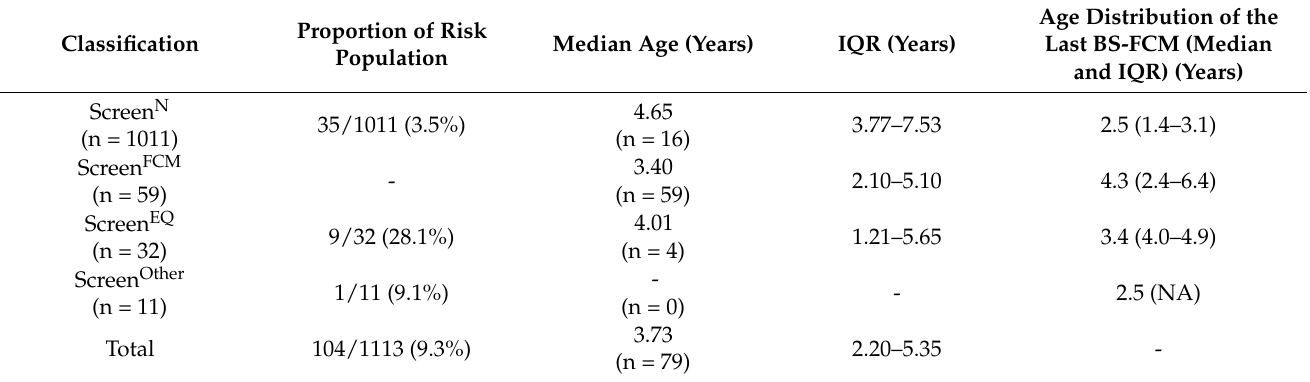
FCM, feline cardiomyopathy; Screen N , Cats classified as normal at breed-screen for FCM; Screen FCM , cats diagnosed with HCM or RCM at breed-screen for FCM; Screen EQ , Cats classified as equivocal at breed-screen for FCM; Screen Other , Cats classified as Other at breed-screen for